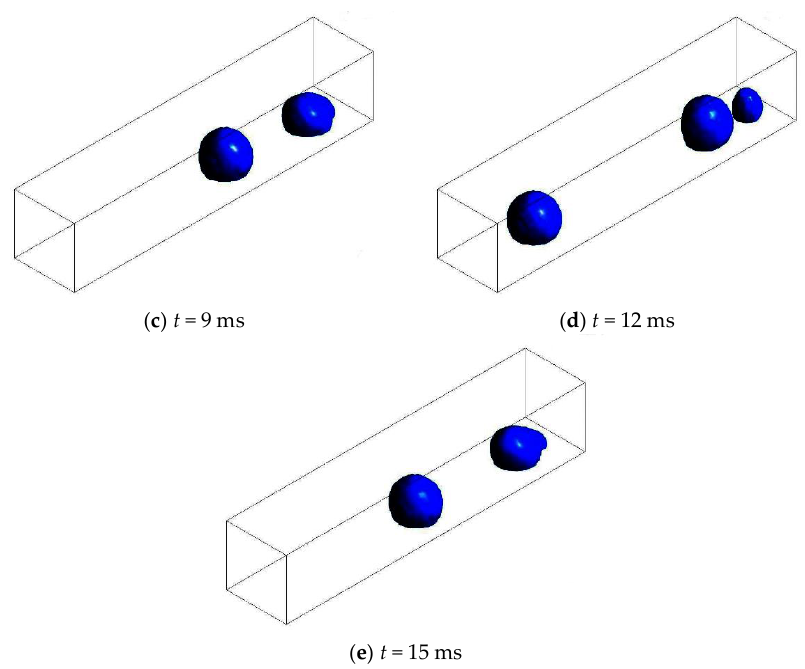
Figure 18. Time evolution of the water droplets emerging from the hole in a hydrophobic GDL surface (the GDL surface contact angle is 135°).